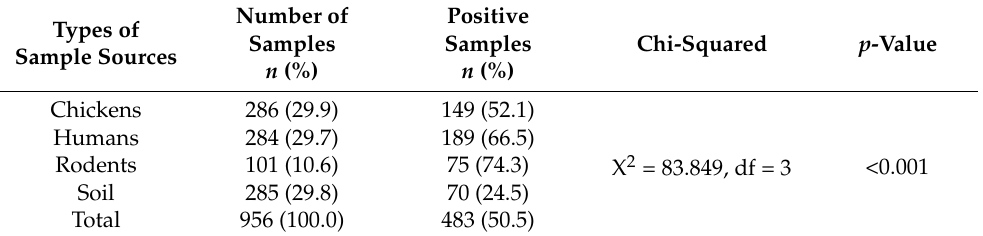
Table 1. Isolation frequencies of Staphylococcus aureus from different sample